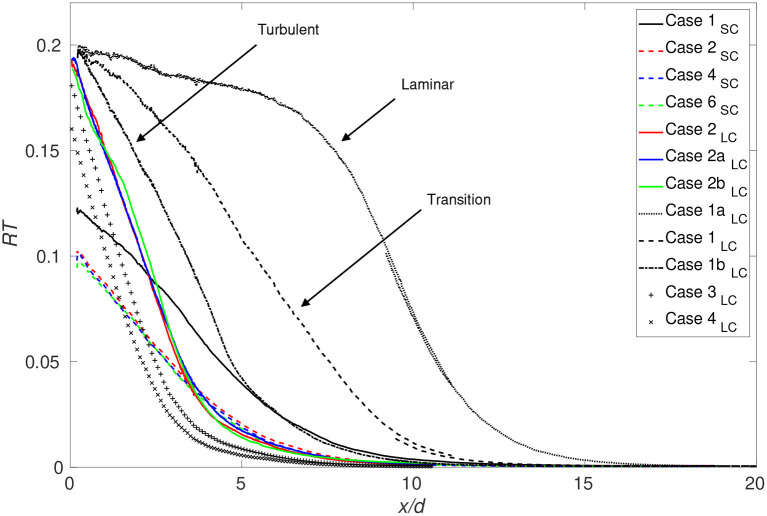
Streamwise evolution of the coefficient RT for all cases investigated.